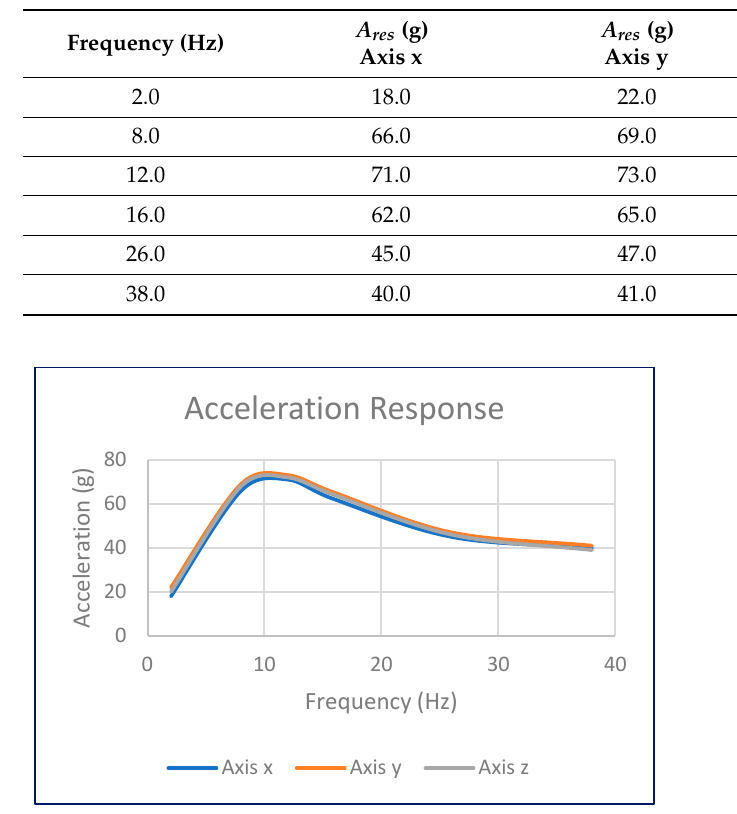
Table 2. Acceleration response.